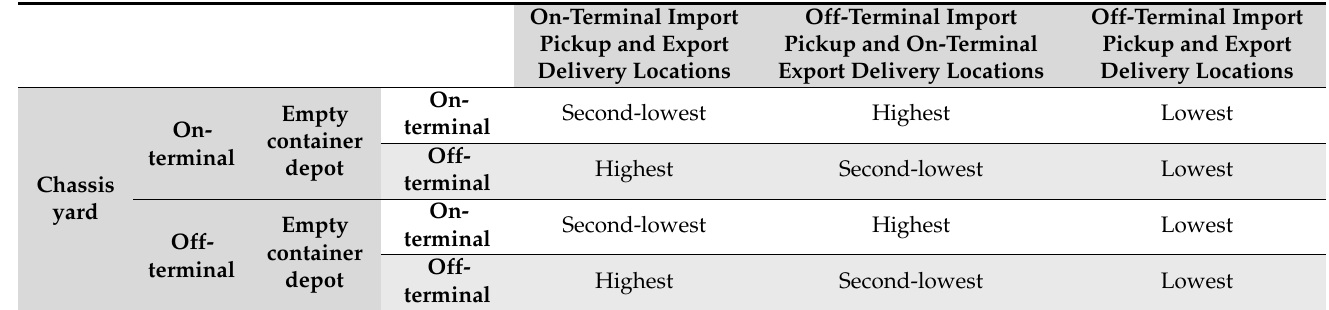
Table 6. The relative ranking of traditional and new practices in placing import pickup and export delivery locations (i.e., scenarios) based on drayage operation time where percent of job nodes is